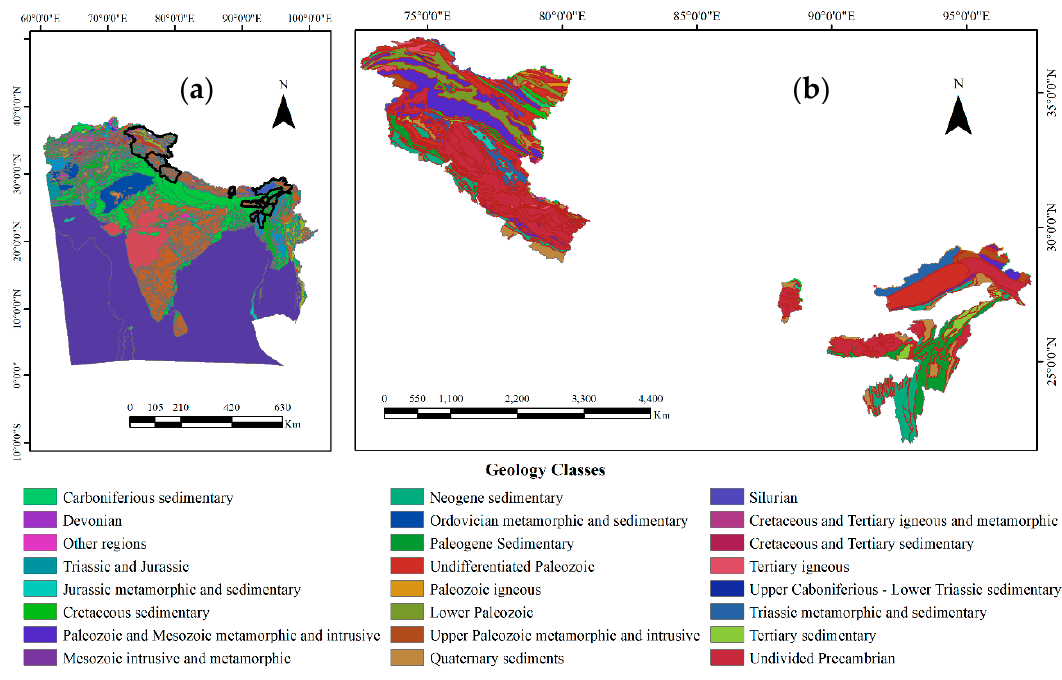
Figure 2. Geology of: ( a ) South Asia highlighting the Indian Himalayan region; and ( b ) the study region (Source: USGS World Geologic Map).